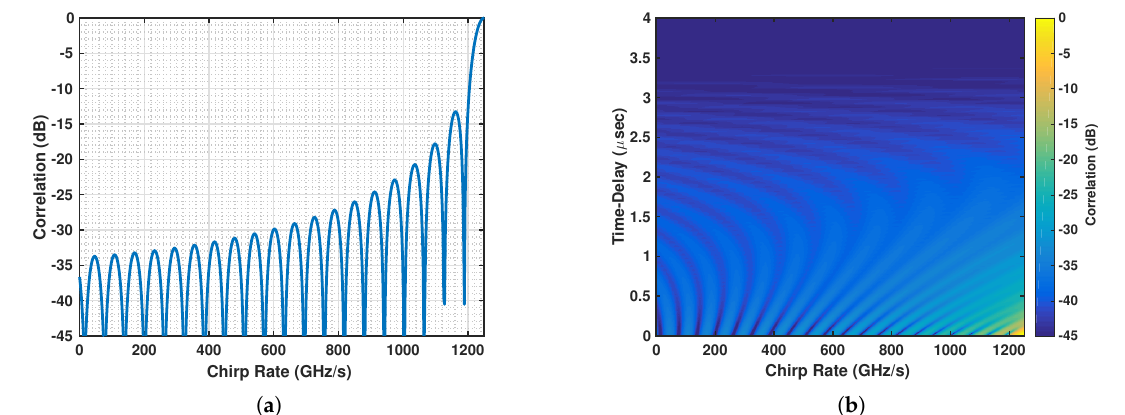
Figure 4. ( a ) Plot of correlation function in Equation (29) as a function of the radar FM rate using b m = b M = B / ( 2 T r ) and ( a ) τ =0, ( b ) varying τ .